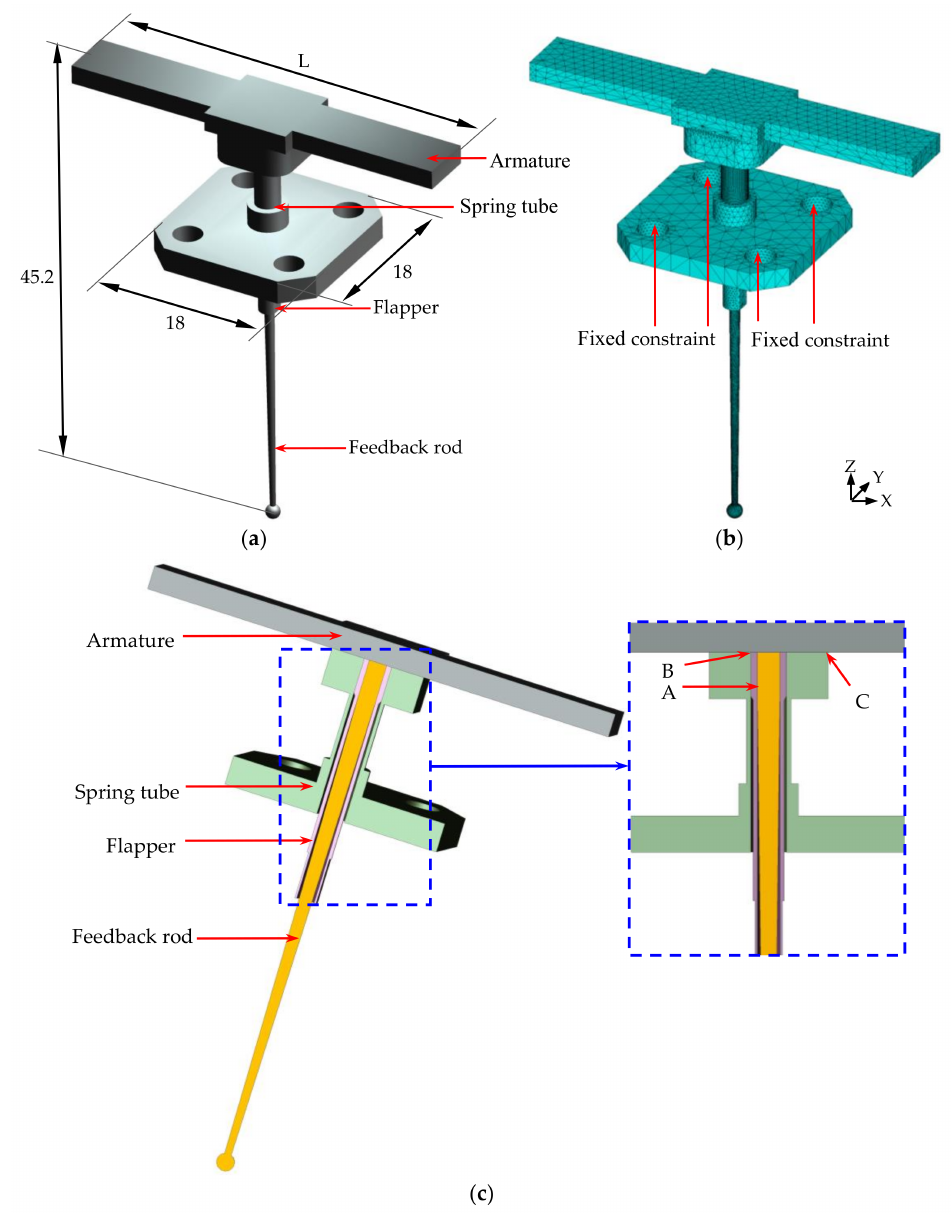
Figure 3. Flapper-armature assembly: ( a ) 3D geometry model of the assembly; ( b ) meshed model and boundary conditions of the assembly; ( c ) assembly